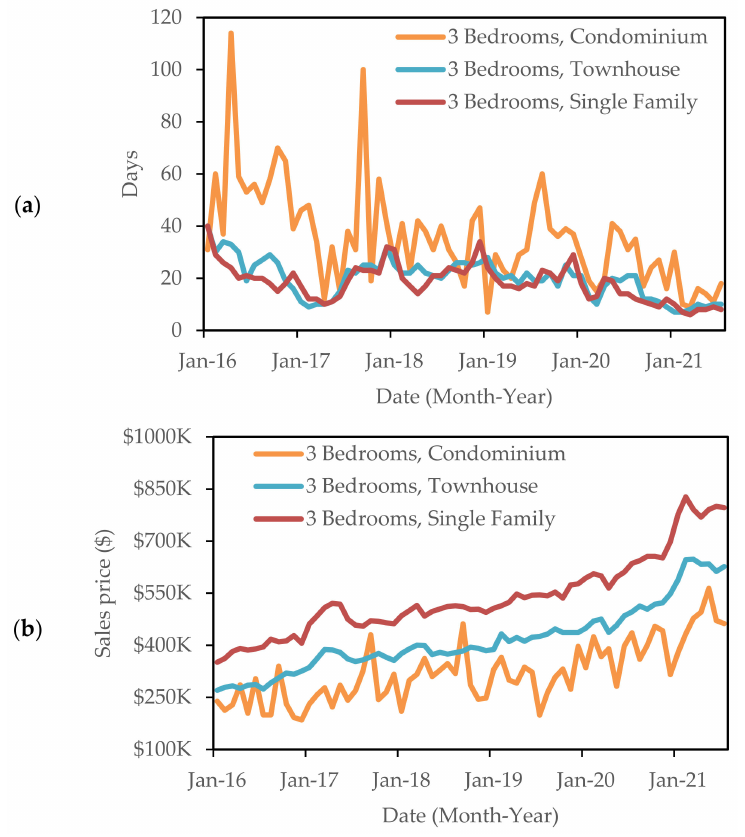
Figure 4. ( a ) Average days on market and ( b ) average sales prices of properties in the housing market of the Waterloo Region